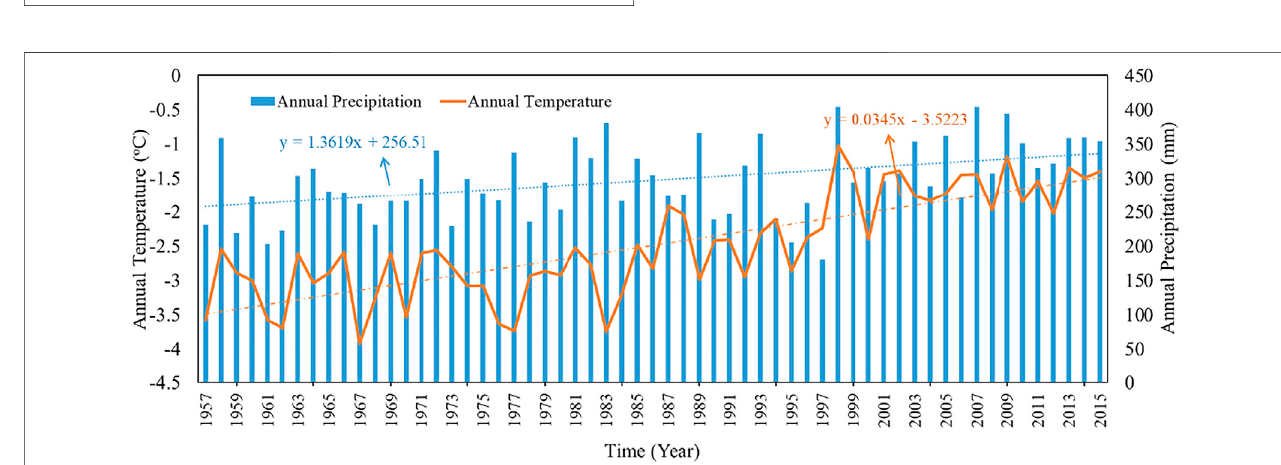
FIGURE 6 | Temperature and precipitation of Tuole meteorological station, 1957 – 2015.